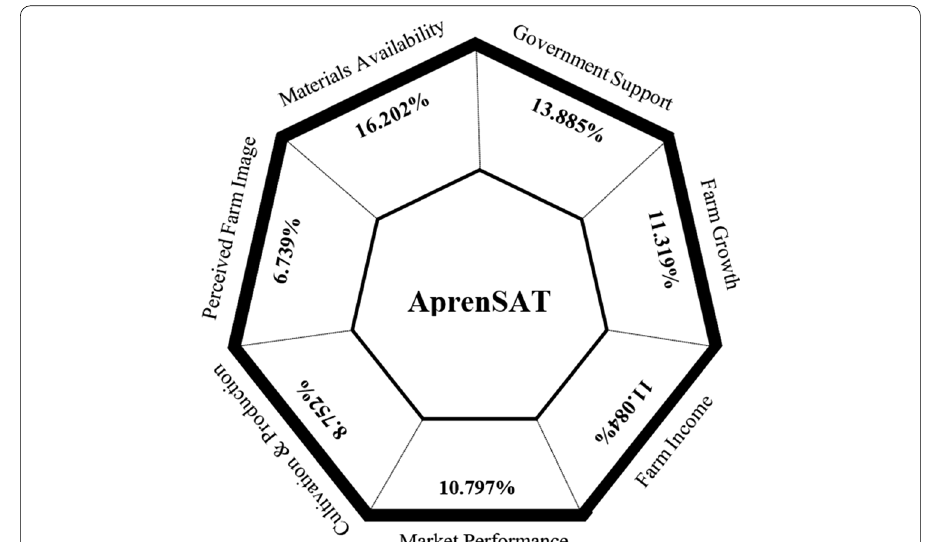
Fig. 2 Seven dimension heptagon model of